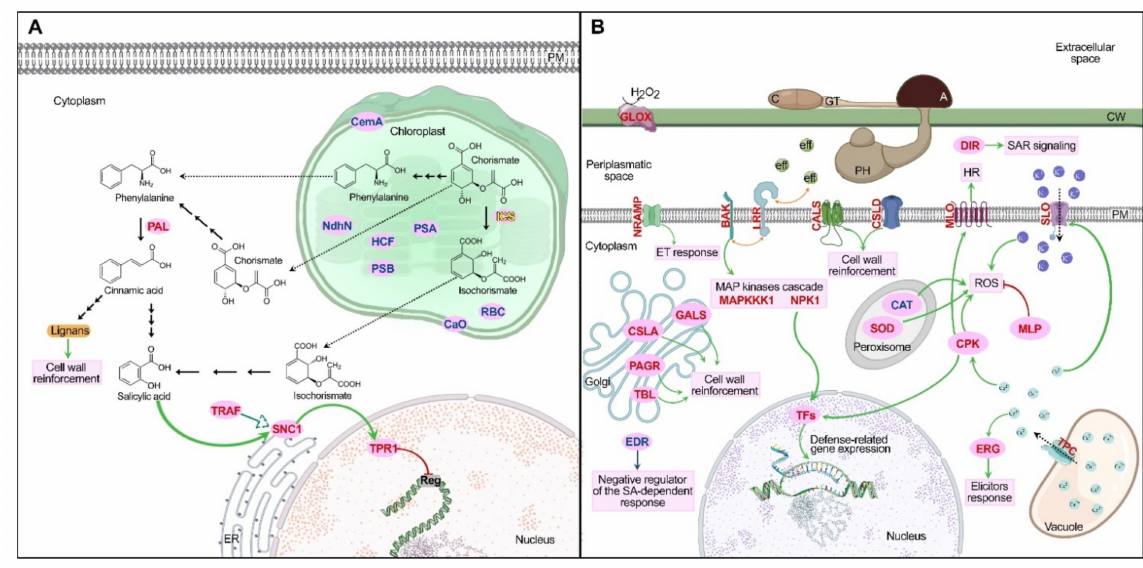
Figure 5. Proposed defense response in P. patens infected with C. gloeosporioides . ( A ) Salicylic acid synthesis mechanism and signaling pathway during the salicylic acid-dependent defense response; also, the downregulated genes from photosynthesis and chloroplast functions. ( B ) Defense strategies of P. patens during infection. Pink ovals indicate enzymes and proteins involved in the defense response. Red, blue and black letters indicate upregulated, downregulated and non-differentially expressed genes, respectively. Green arrows indicate activation, the red trunked line indicates inhibition, the double-headed orange arrows indicate possible interaction, the dotted arrows represent movement from an intracellular space to another and the consecutive black arrows indicate various intermediate reactions. C: conidium; GT: germination tube; A: appressorium; PH: primary hyphae; CW: cell wall; PM plasmatic membrane; HR: hypersensitive response; ROS: reactive oxygen species; ICS: Isochorismate synthase; MAPKKK1: Mitogen-activated protein kinase kinase kinase 1; NPK1: Mitogen-activated protein kinase kinase kinase NPK1; eff: fungal effectors. For other abbreviations, see the description of Figure